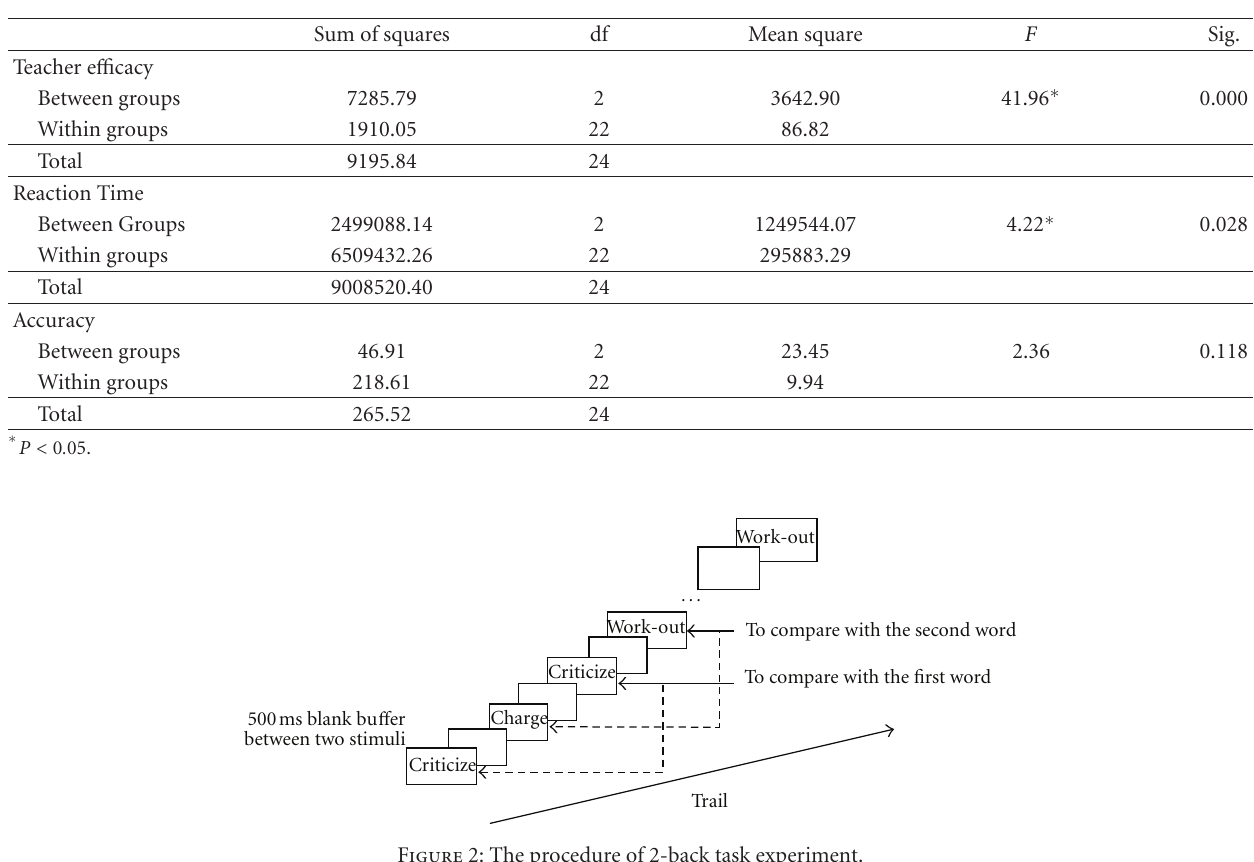
Table 2: The ANOVA analysis for teacher e ffi cacy, reaction time, and accuracy.